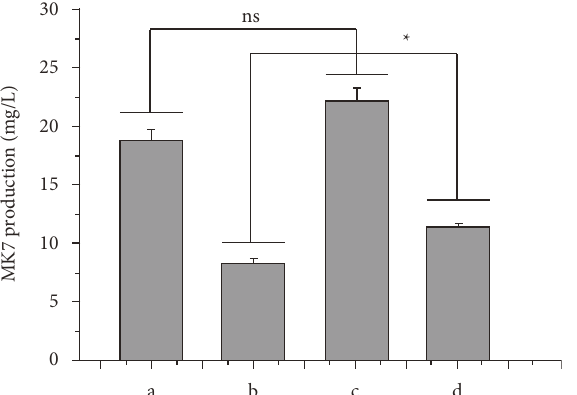
Figure 5: The MK-7 production of Bacillus subtilis natto. (a) Total MK-7 production of Bacillus subtilis natto. (b) Extracellular MK-7 production of Bacillus subtilis natto (BN-20644). (c) Total MK-7 production of Bacillus subtilis BslA. (d) Extracellular MK-7 production of Bacillus subtilis BslA.